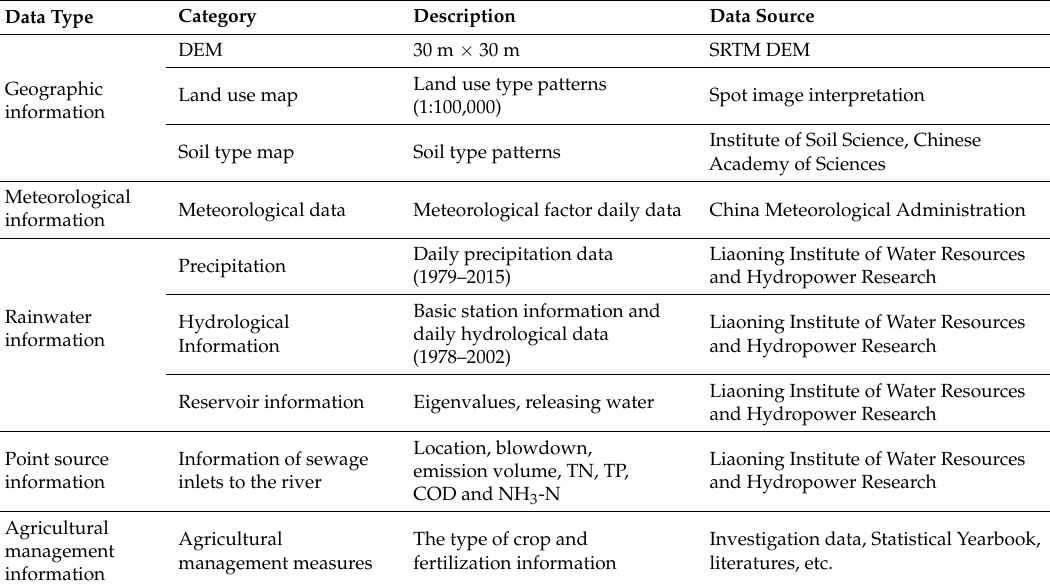
Table 2. Geography, climate and agricultural data used for the SWAT